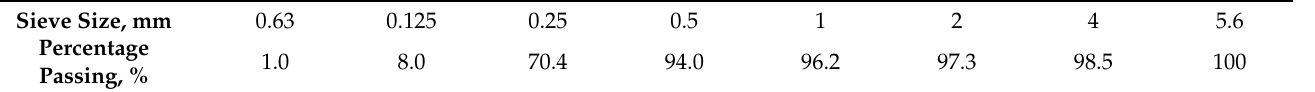
Table 1. Sandy soil particle size distribution.